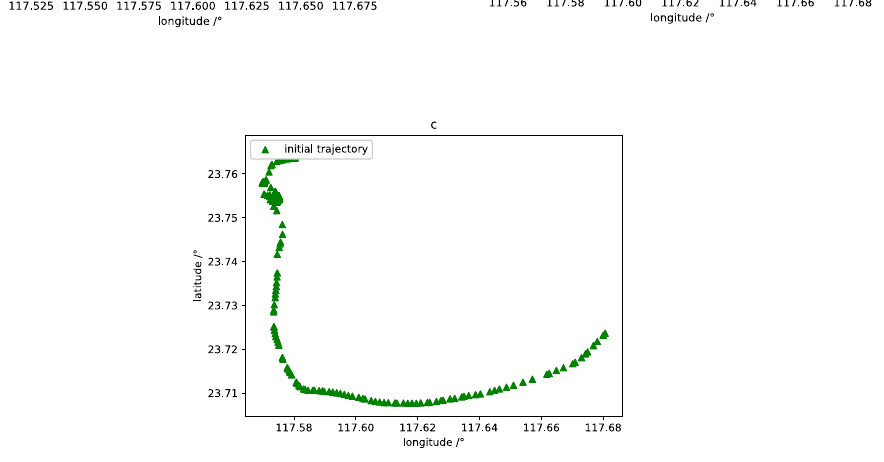
to T 1 . S 2 represents segments. The distance of P 2 i 1